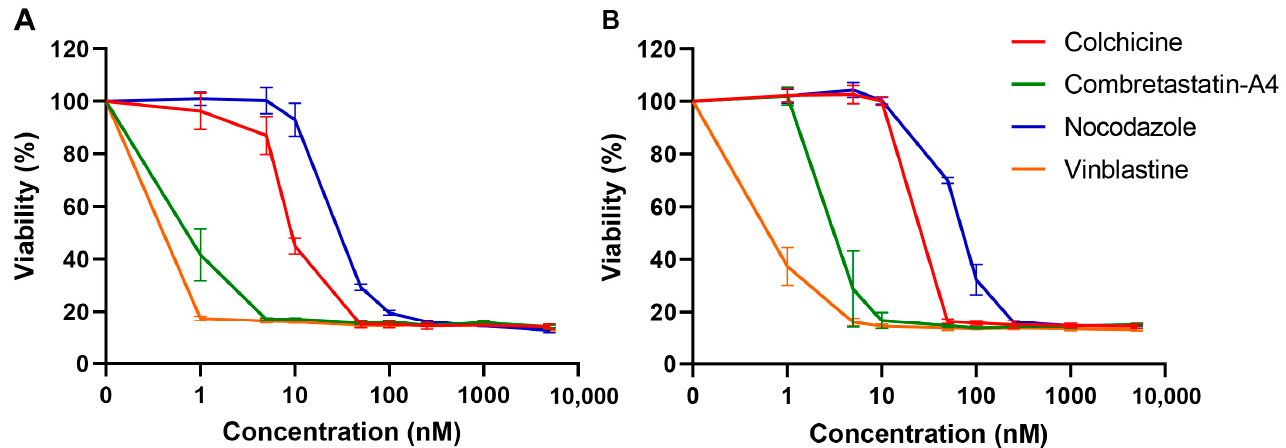
Figure 6. Effect of the compounds on the viability of ( A ) HeLa cells and ( B ) RPE-1 cells. Cells were incubated for 48 h with several concentrations of the indicated compounds. The percentage of viable cells was calculated following a PrestoBlue assay, with 100% corresponding to cells treated with DMSO without the depolymerizing agent. Data are presented as means ± SEM of three independent experiments.